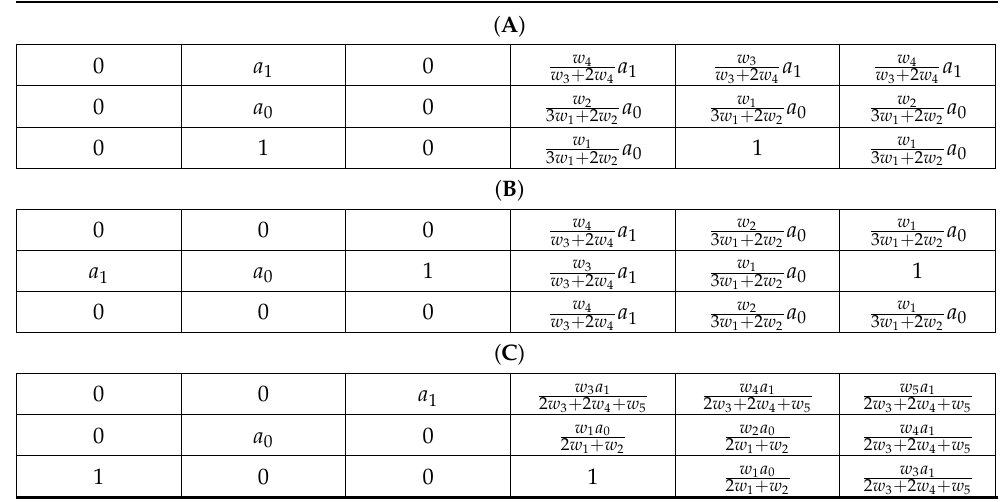
Table 2. The 3 × 3 G-L fractional differential masks and 3 × 3 spatial domain fractional differential masks in ( A ) negative x-direction; ( B ) negative y-direction; ( C ) upper-right diagonal direction.